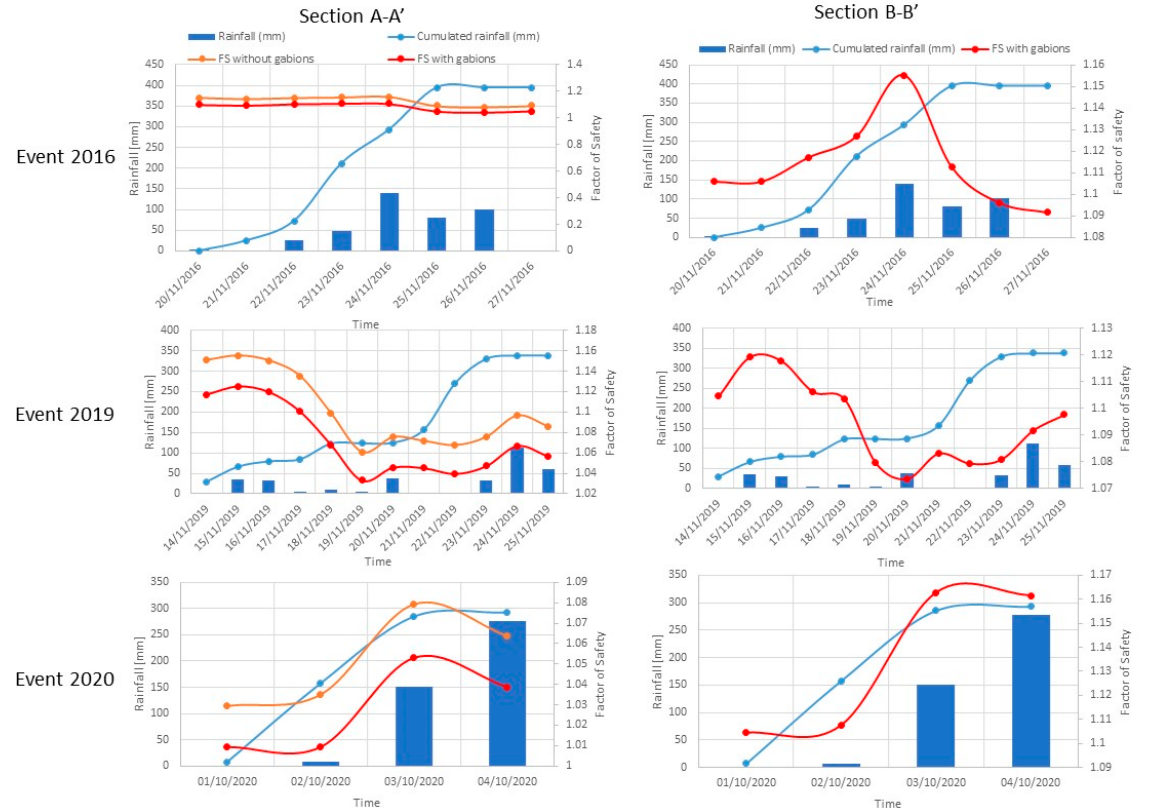
Figure 13. Variation of the FS of the most critical slip surface in the presence (red) and absence (orange) of gabion walls in relation to rainfall (dark blue) and cumulated rainfall (light blue).